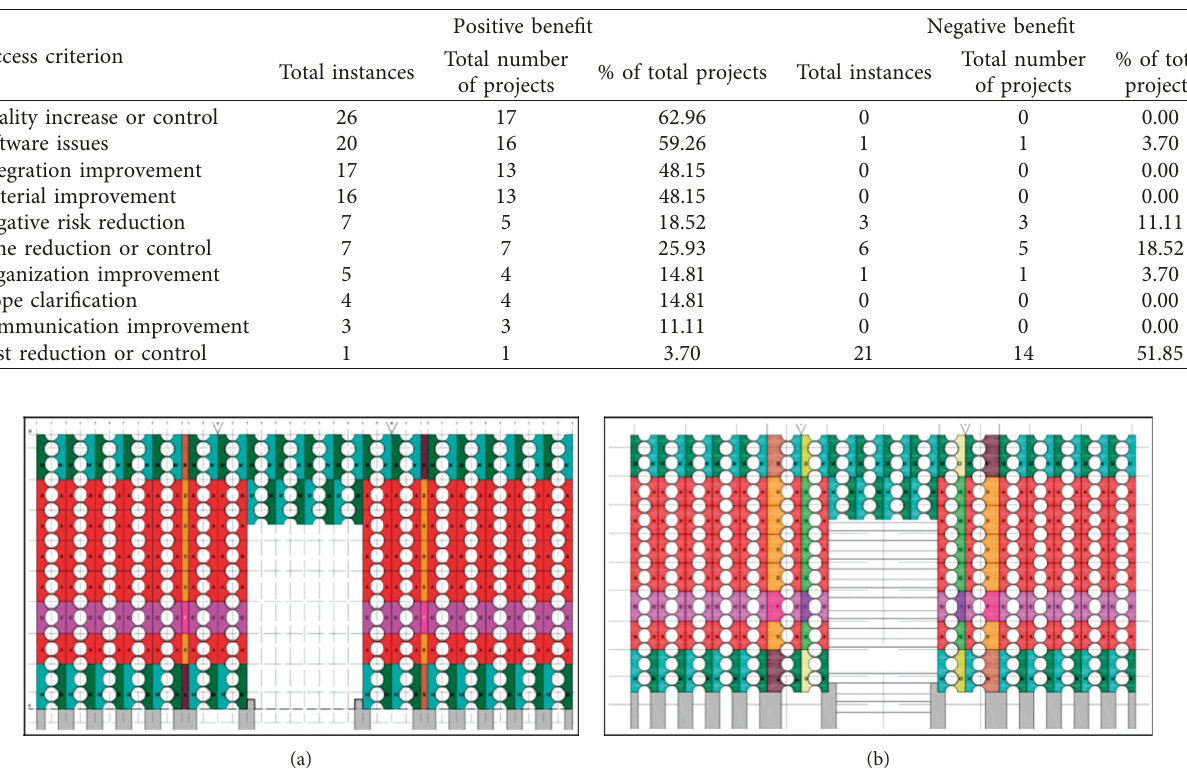
Table 4: Success criteria ranking of using digital